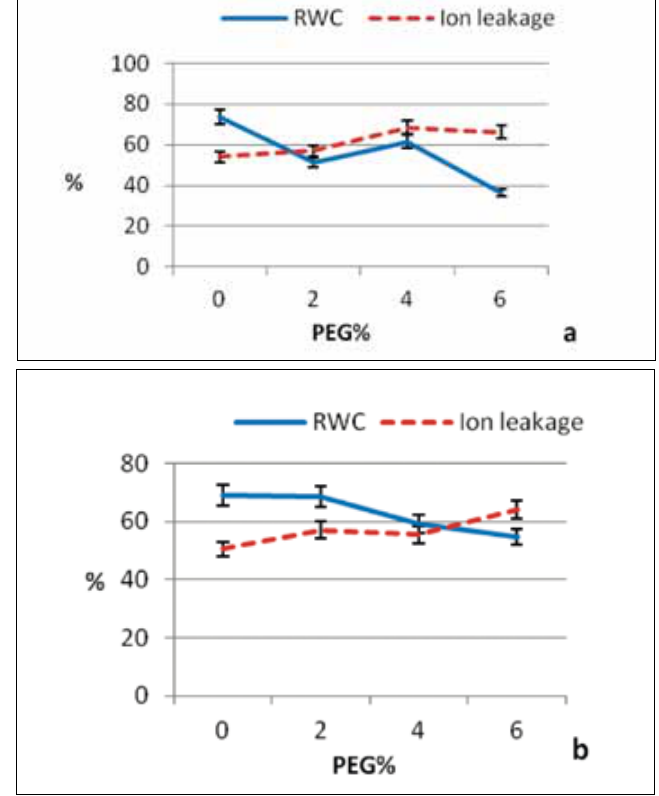
Fig. 1 - Changes in leaf water content (RWC) and ion leakage in two fig cultivars: ‘Sabz’ (a) and ‘Siah’ (b).